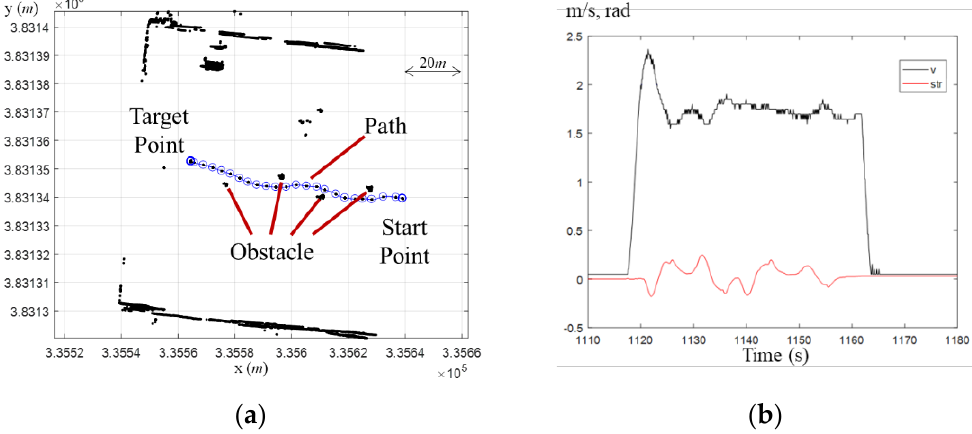
Figure 12. Driving test among obstacles. ( a ) Path of UGV and point cloud data during autonomous driving. ( b ) Steering and speed of UGV.